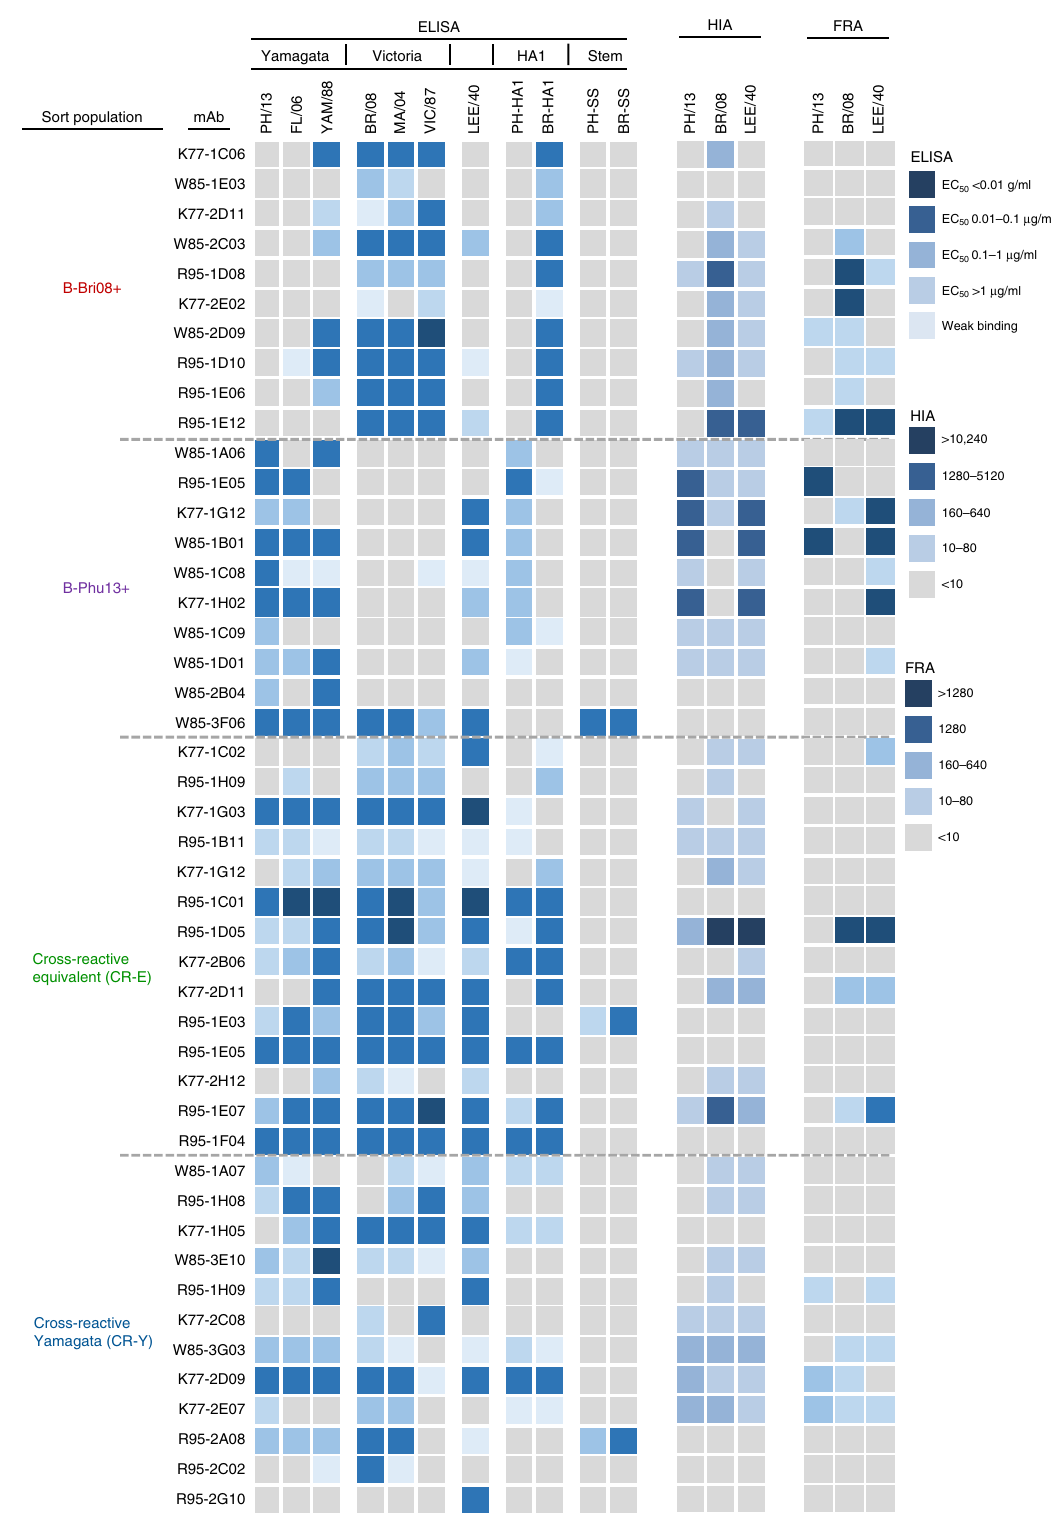
Fig. 3 Speci fi city and antiviral activity of recovered human monoclonal antibodies. mAbs were assessed for binding to diverse IBV HA, HA1 and HA stem proteins by ELISA, with the strength of binding calculated as the concentration yielding half-maximal binding (EC50) and denoted by the indicated shading. HIA was assessed as the ability of mAb to inhibit hemagglutination of red blood cells. The dilution of a 1 mg/mL stock with positive HIA signal is denoted by the indicated shading. The neutralisation of IBV viruses was assessed by focus reduction assay (FRA). The dilution of a 1 mg/mL stock, which neutralised 50% of the virus control is denoted by the indicated